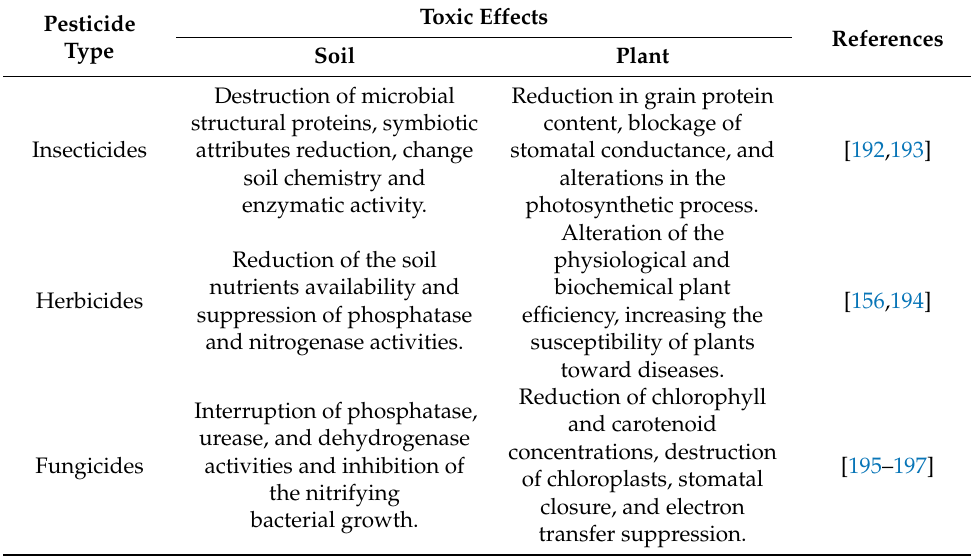
Table 6. Toxic effects of pesticides on agricultural soil and